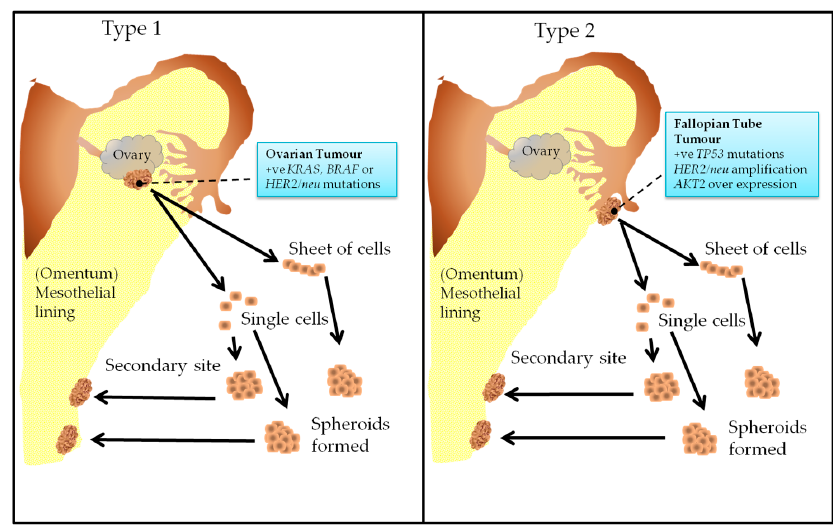
Figure 1. Classification of Epithelial Ovarian Cancer: Type 1: Tumors are thought to evolve from the surface epithelium and the Müllerian inclusions of the ovary. Type 2: Tumors are thought to evolve from the intra-epithelium of the Fallopian tube.